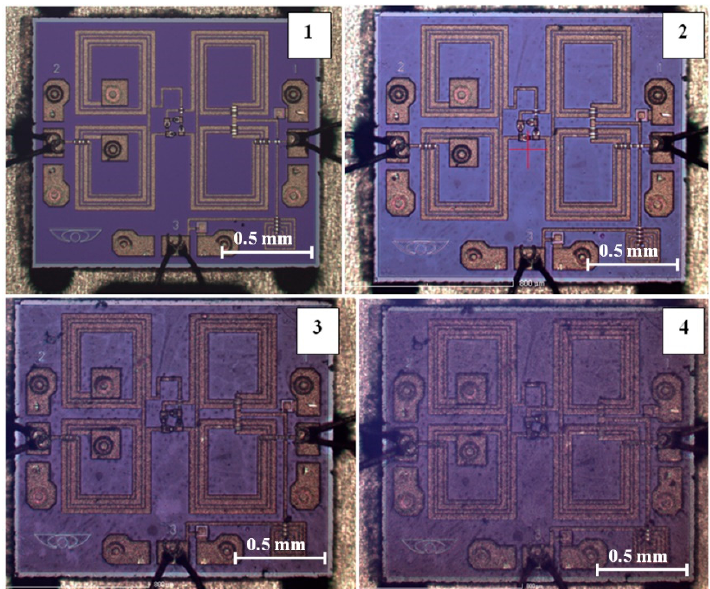
Figure 6. Micrograph of the microcircuit at all stages of coating deposition: ( 1 )—before deposition; ( 2 )—after depositing the first layer (Al 2 O 3 ), the coating total thickness is 0.5 µm; ( 3 )—after depositing the second layer (AlN), the coating total thickness is 1 µm; ( 4 )—after depositing the third layer (Al 2 O 3 ), the coating total thickness is 1.5 µm.